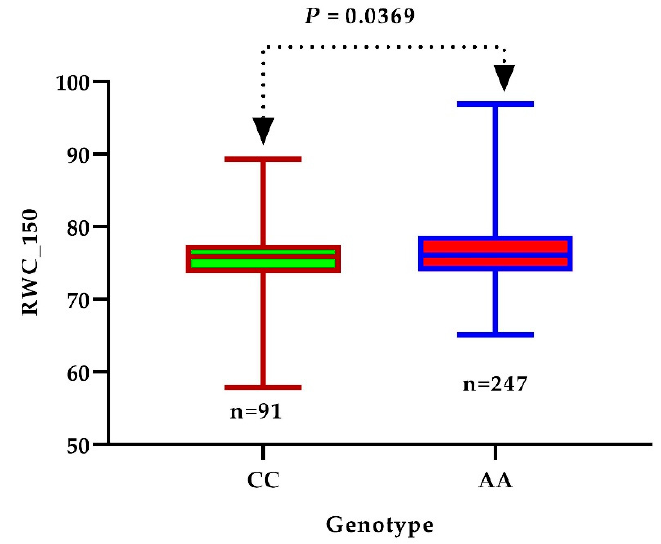
Figure 5. Difference of relative water content, RWC_150, between two haplotypes. In the box plot, the center line shows the median, the box limits are the upper and lower quartiles, and the whisker depicts the range of the data; n shows the number of accessions with the same genotype. Significance of difference ( p -value) was analyzed with a two-tailed t test.